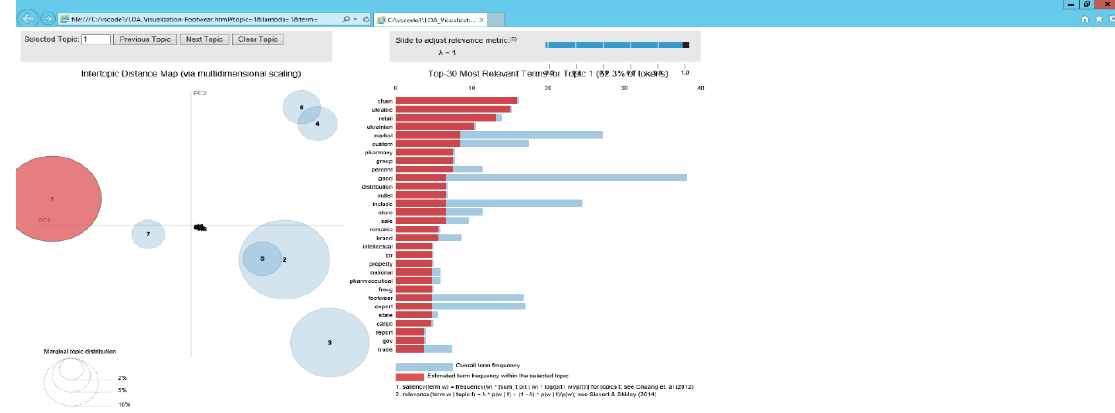
Figure 7. Footwear: Topic 1. This image shows the LDAVis screen with Topic 1 selected .